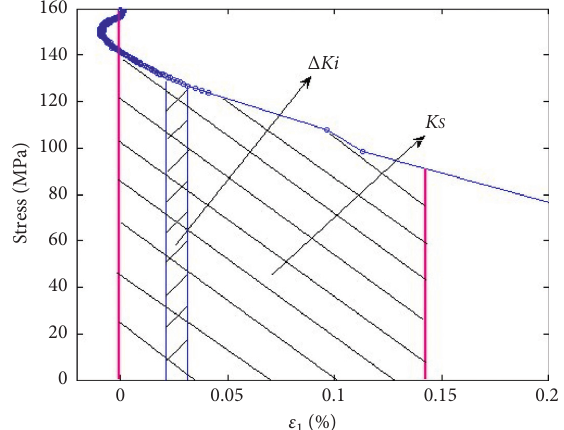
Figure 10: Schematic diagram of calculation K unloading and radial unloading paths.